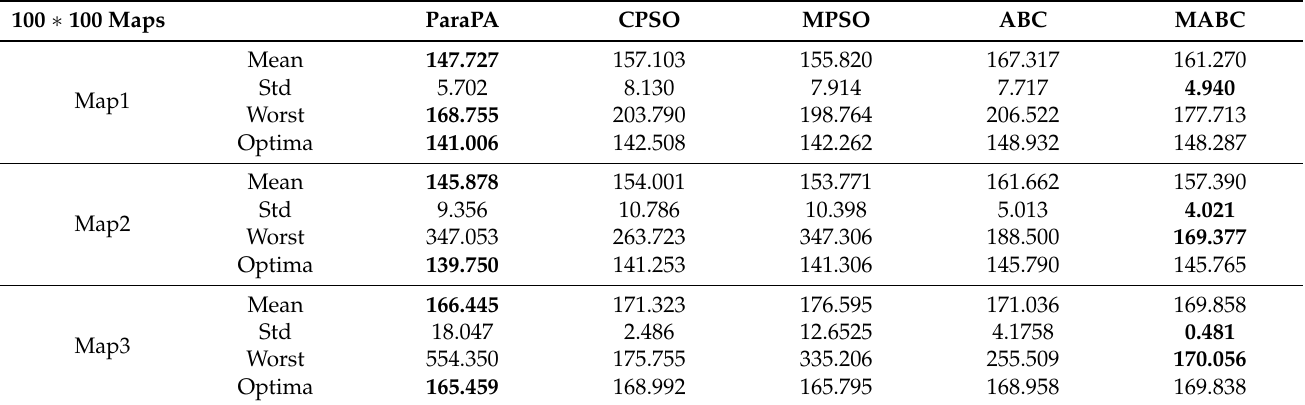
Table 5. Convergence performance on 100 × 100 maps.